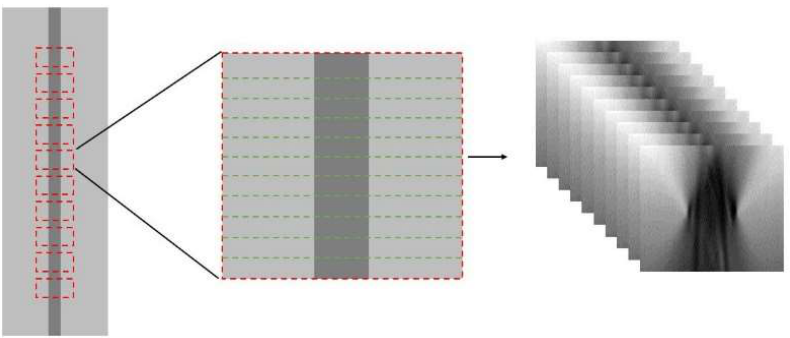
Figure 5. Process to collect TSOM image dataset.